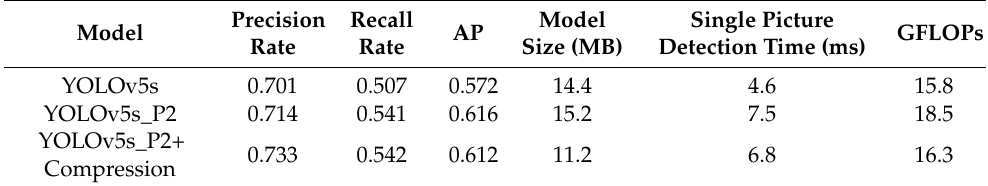
Table 2. Experimental results of our